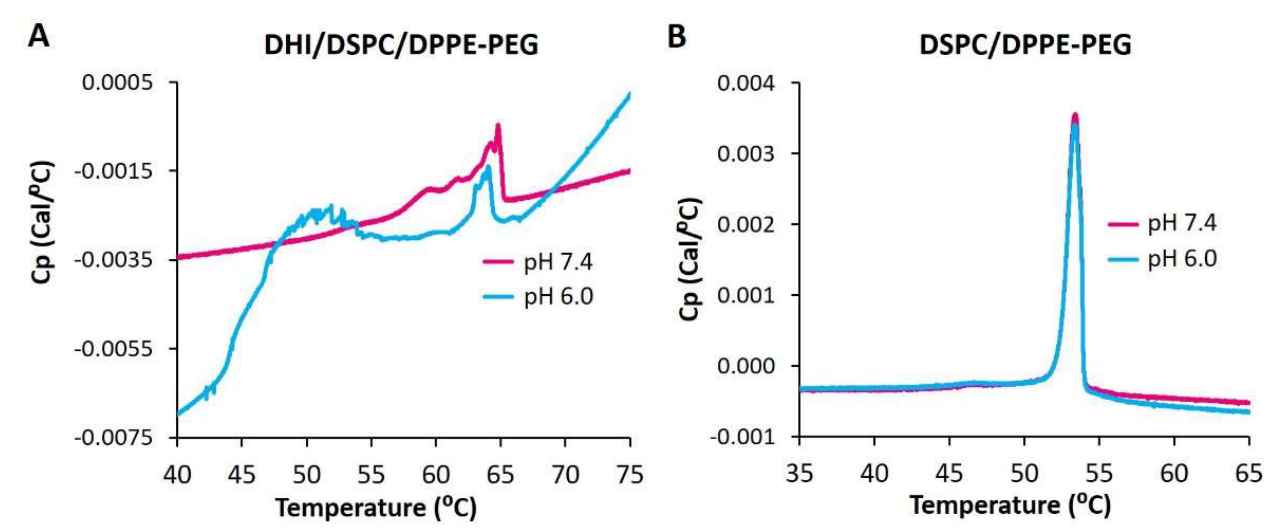
Figure 8. DSC thermograms of pH-sensitive ICL (DHI/DSPC/DPPE-PEG) ( A ) and pH-insensitive stealth liposome DSPC/DPPE-PEG ( B ) at pH 7.4 and 6.0. stealth liposome DSPC/DPPE-PEG ( B ) at pH 7.4 and